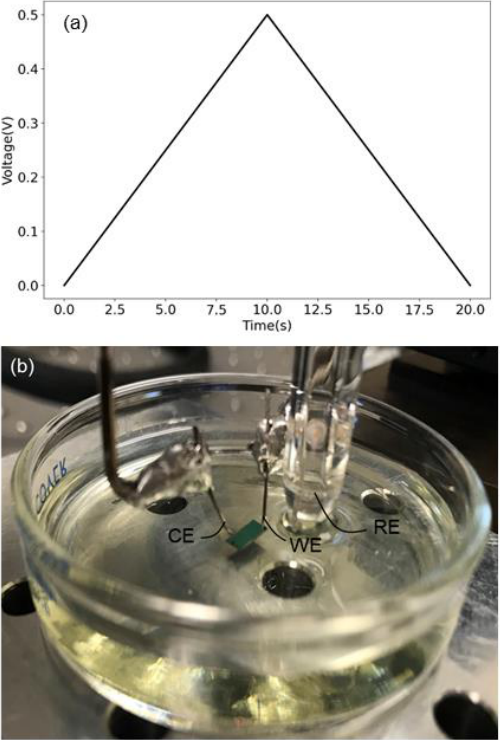
Figure A1. ( a ) Example triangular voltage waveform applied in the CV measurements (0.5 V peak, 50 mV/s scan rate). ( b ) Full CV set-up showing probe needles contacting a chip (green) bearing a Au working electrode (WE) and a Pt counter electrode (CE), and a Ag/AgCl reference electrode (RE).